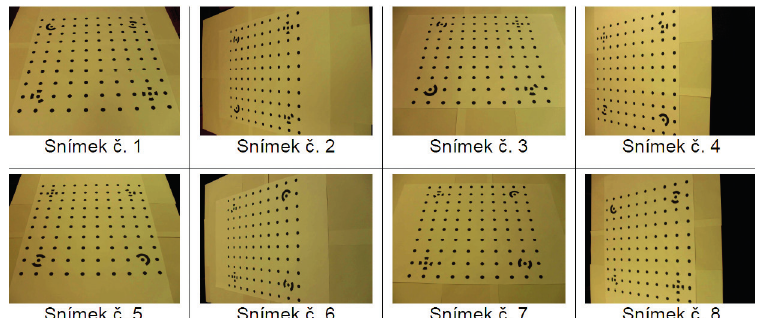
Fig. 2. Photographs of the 2D geodetic